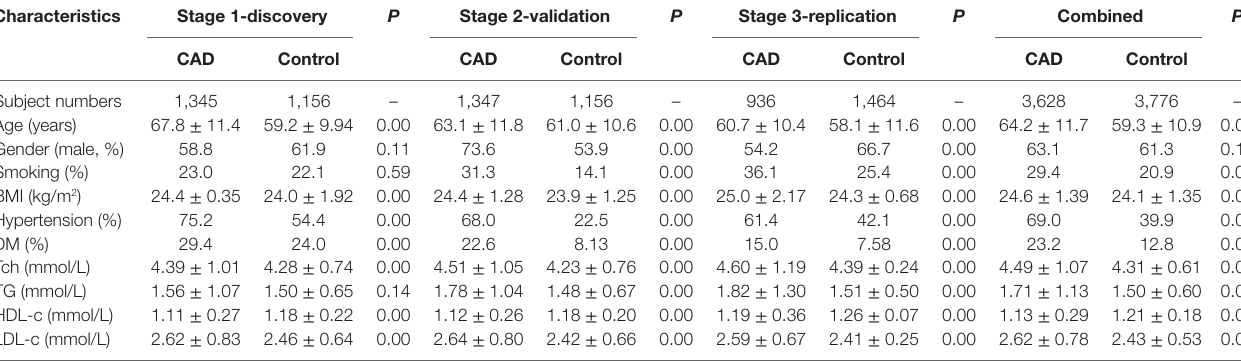
TaBle 1 | Clinical characteristics of the studied Chinese Han population.